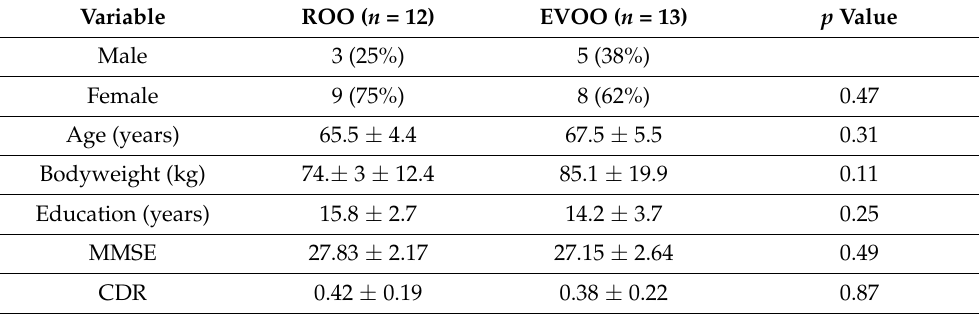
Table 1. Baseline demographic and clinical characteristics of study participants.